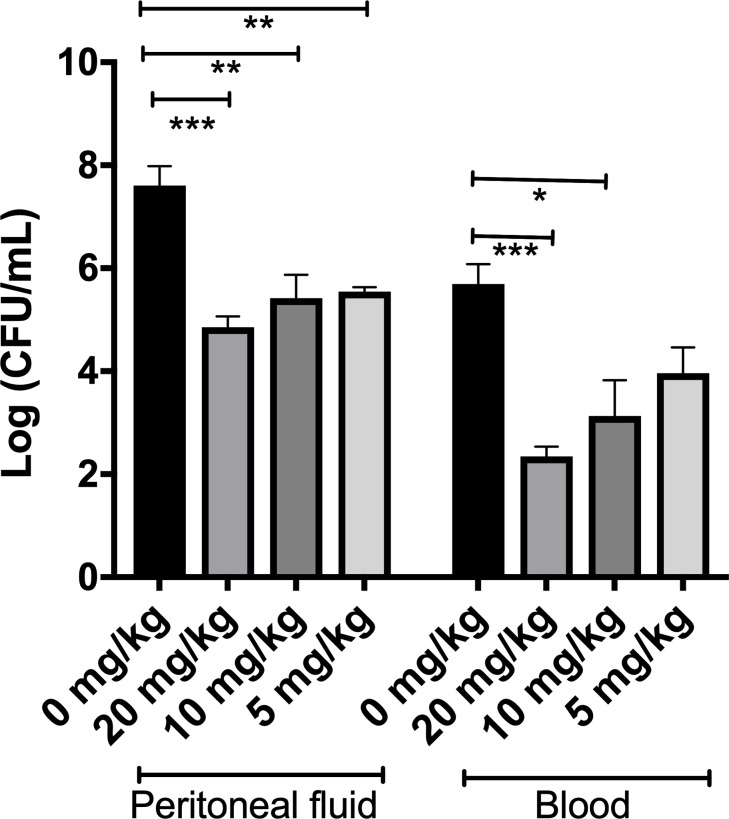
DAN2 treated mice have reduced bacterial loads both in peritoneal fluid and blood.Four mice were infected and treated with 0 mg/kg, 20 mg/kg, 10 mg/kg and 5 mg/kg of DAN2 individually and bacterial count was determined after 6 hours of infections. The error bars represent the standard deviation of the mean. The number of asterisks was used to denote the extent of statistical significance amongst groups (* denotes p < 0.05, ** denotes p < 0.005, *** denotes p < 0.0005).